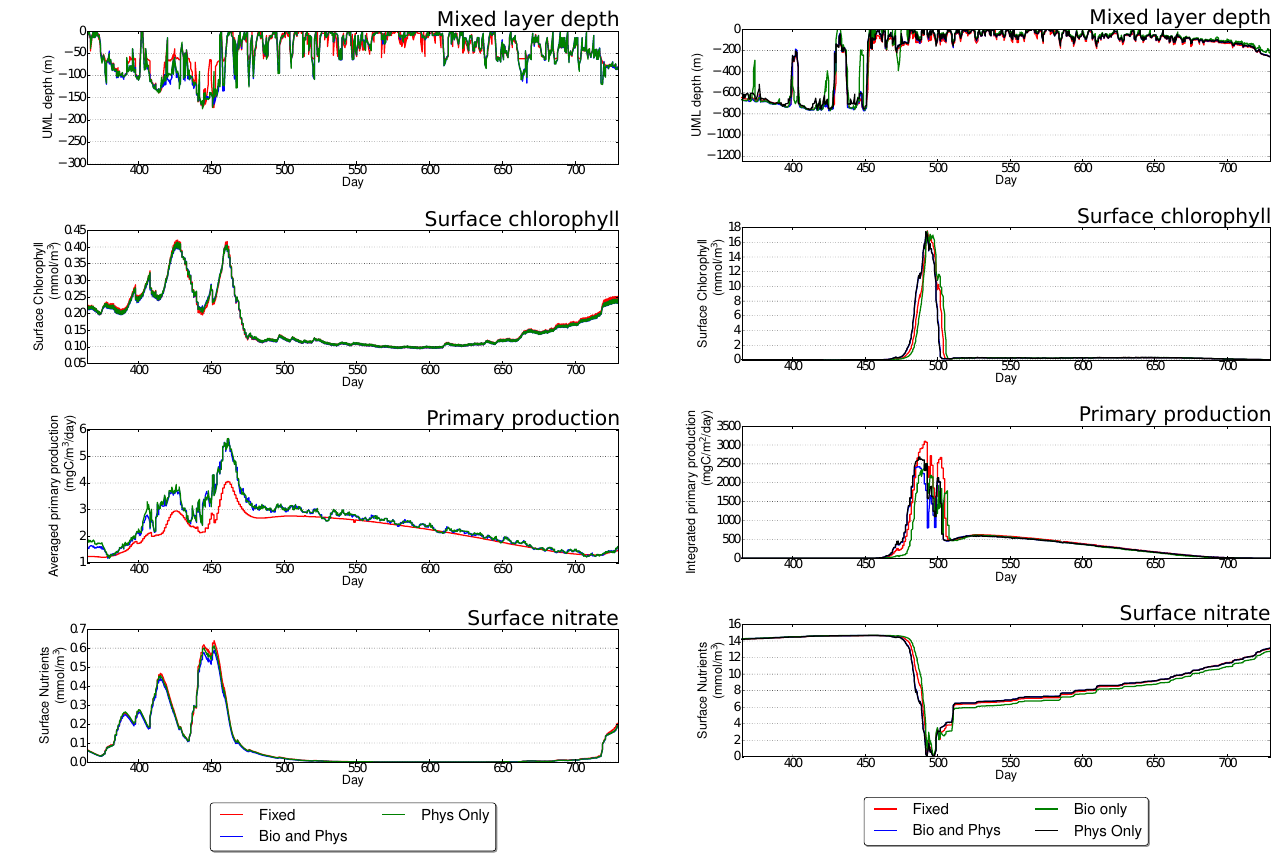
Fig. 13. Summary of results comparing different adaptivity metrics against measured data and the high-resolution (2.5m) fixed-mesh simulation at Bermuda. Note that the simulations using PAR and biology only failed after only a few adapts.